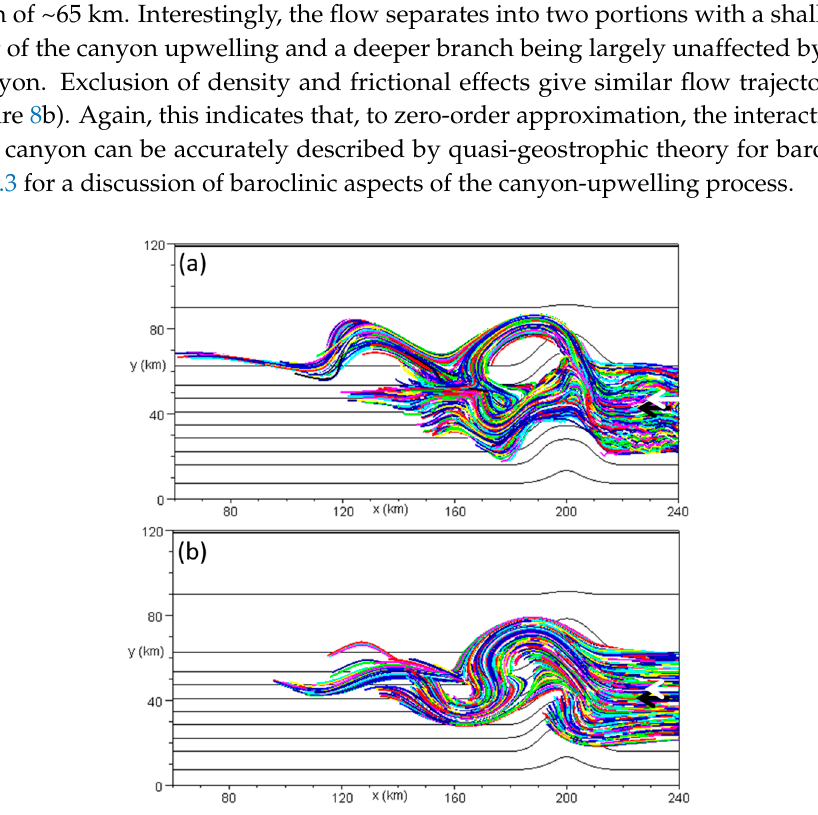
Figure 8 . Canyon-upwelling scenario based on trajectories of 3000 passive near-bottom drifters from day 5 to day 25 of the simulation: ( a ) the result for the full model configuration; and ( b ) the result for a model run with uniform seawater density and zero friction. Black lines are isobaths. Arrows indicate the overall flow direction.